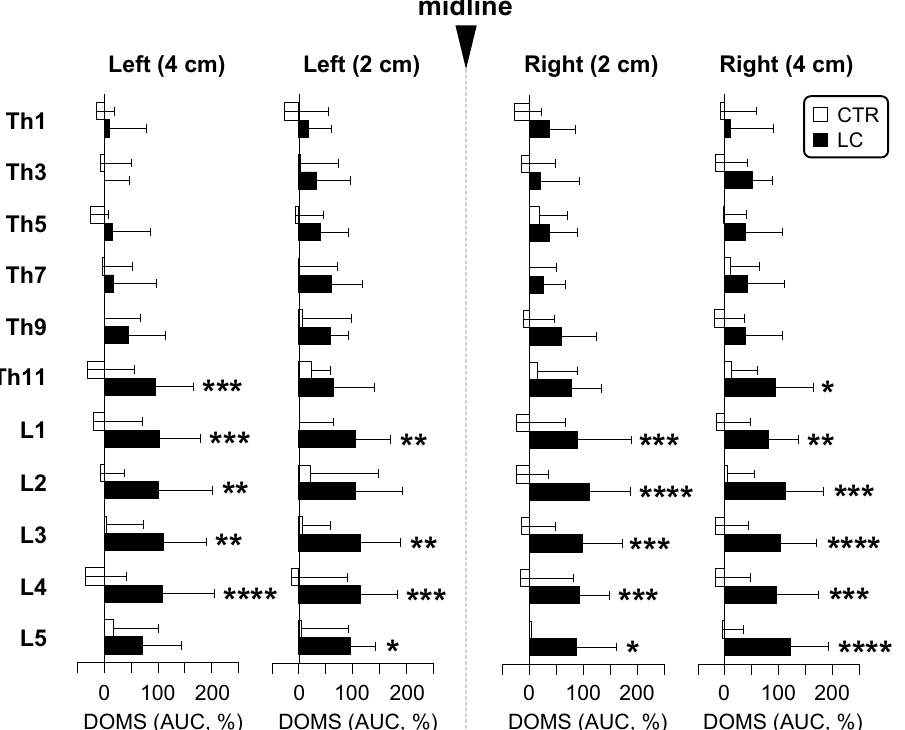
Figure 7. Magnitude of DOMS in the thoracolumbar areas after lengthening contractions (LCs). The area under the curve (AUC) of normalised PPTs, which was calculated from data at 0 (BL), 24, and 48 h in Fig. 6, was used as the magnitude of the DOMS in each vertebral segment of four measurement points (i.e. left 4 cm, left 2 cm, right 2 cm, and right 4 cm). Note significantly higher magnitude of DOMS in the LC group than in the CTR at segments Th11–L5 (* p < 0.05, ** p < 0.01, *** p < 0.001, and **** p < 0.0001, CTR (n = 12) vs. LC (n = 12), two-way repeated measures ANOVA followed by Sidak’s multiple comparison